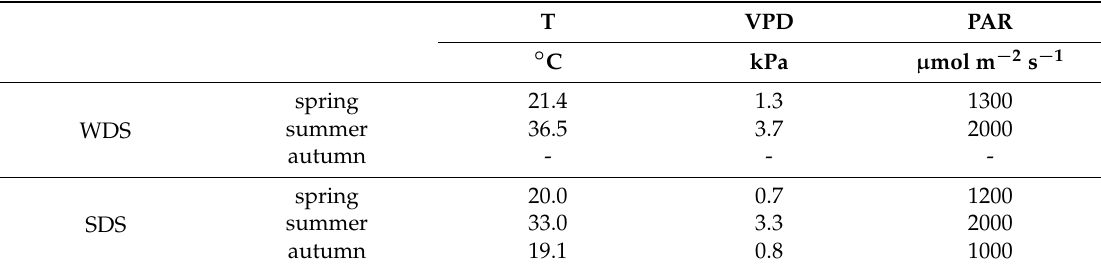
Figure A2. Details of the ecosystem types under investigation: ( A ) the Hungarian forest–steppe transitional biome (WDS); and ( B ) the Mediterranean shrubland (SDS). Table A1. Microclimate conditions inside the cuvette during gas exchange measurements in the two study sites. T: leaf temperature; VPD: vapour pressure deficit; PAR: photosynthetic active radiation.